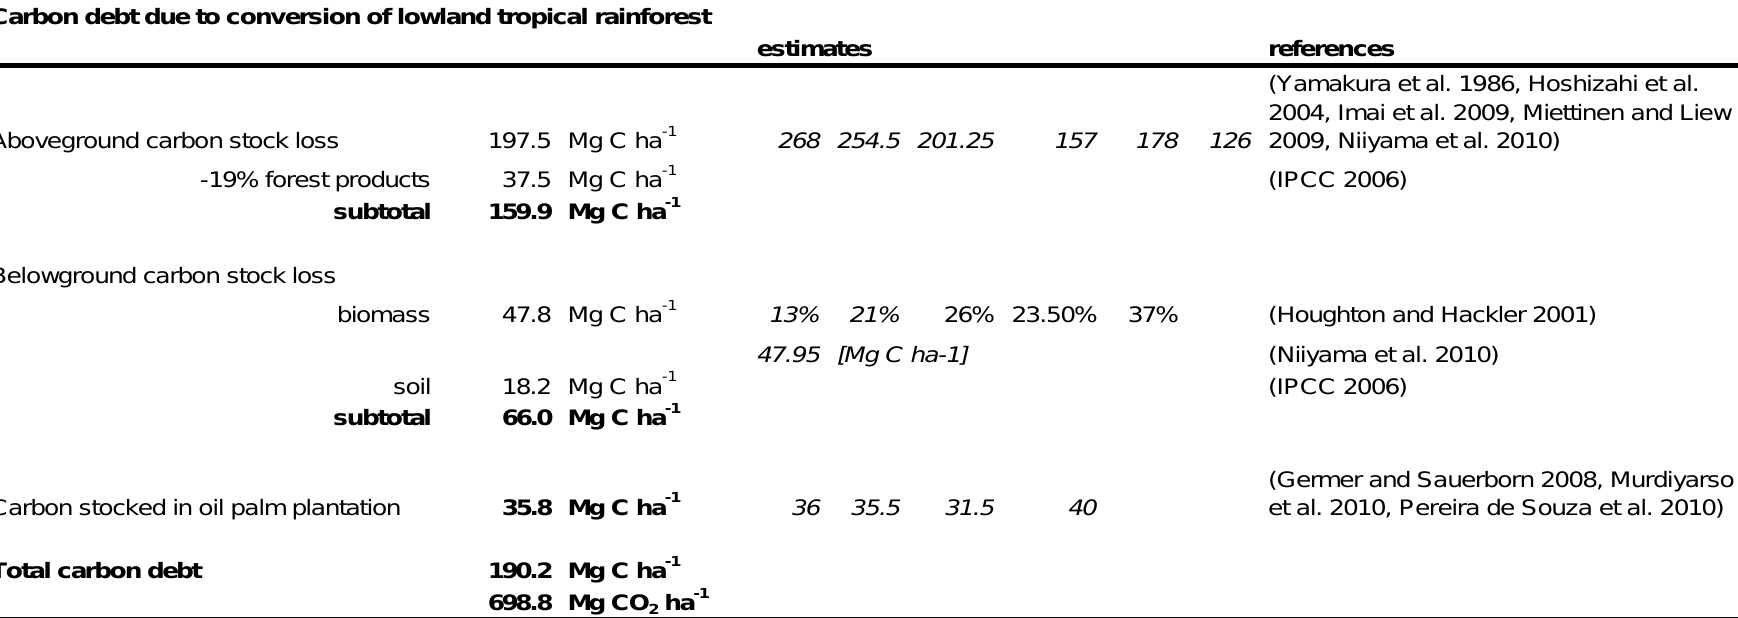
Table A1.1. Carbon debt calculation of Malaysia